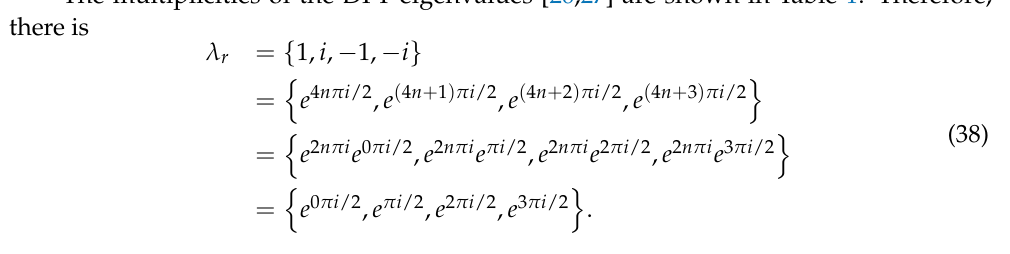
Table 1. Multiplicities of the DFT eigenvalues.